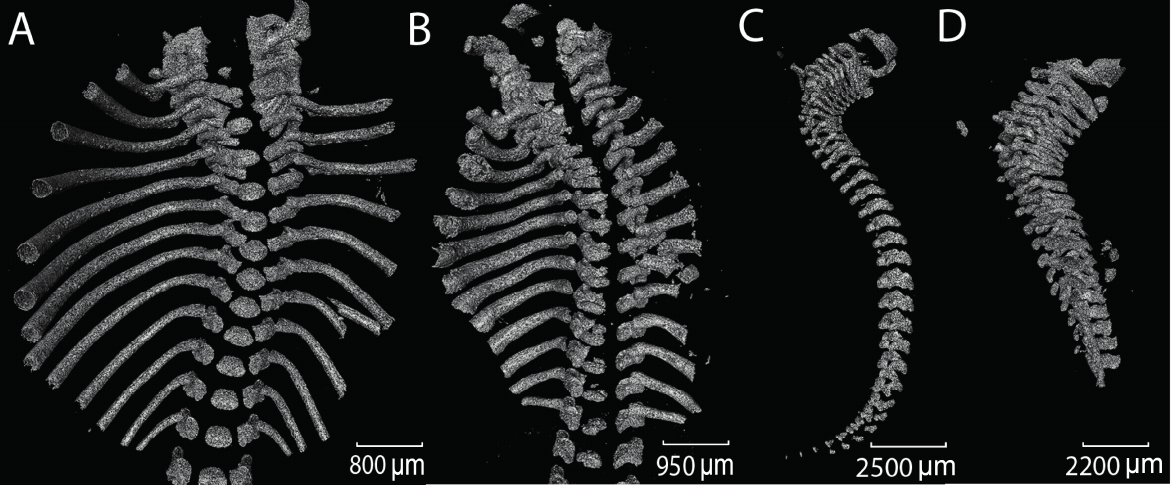
Figure 2. Three-dimensional reconstructions from X-ray micro-CT data of axial skeleton and ribs. ( A and C ) WT mouse; and ( B and D ) Col11a1-deficient mouse; Differences in spinal